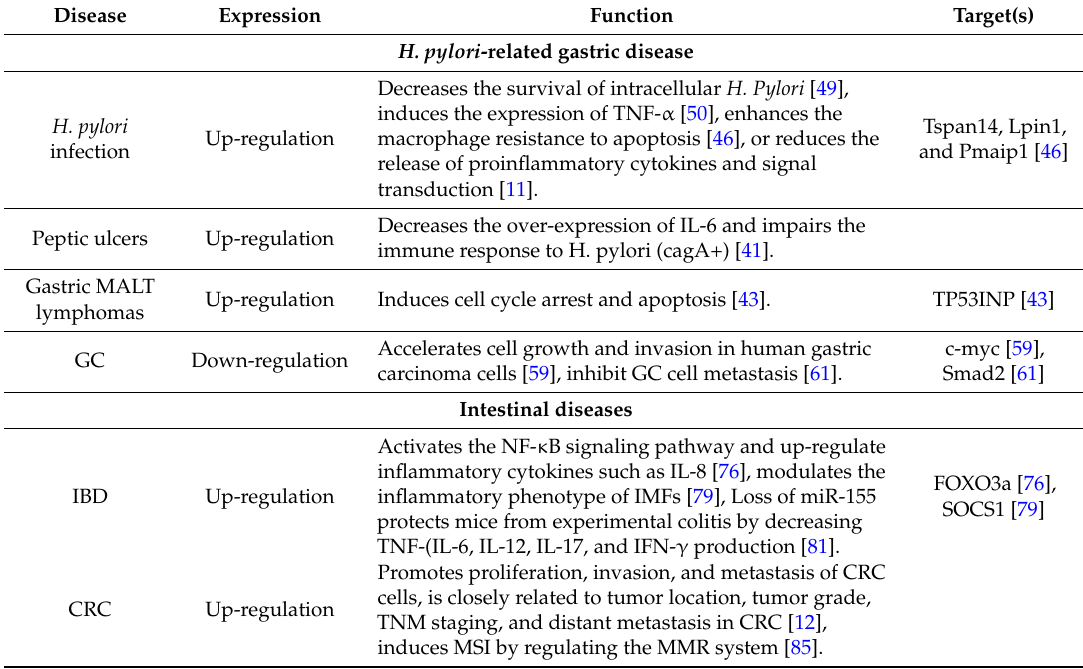
Table 1. Role of miR-155 in diseases of the gastrointestinal